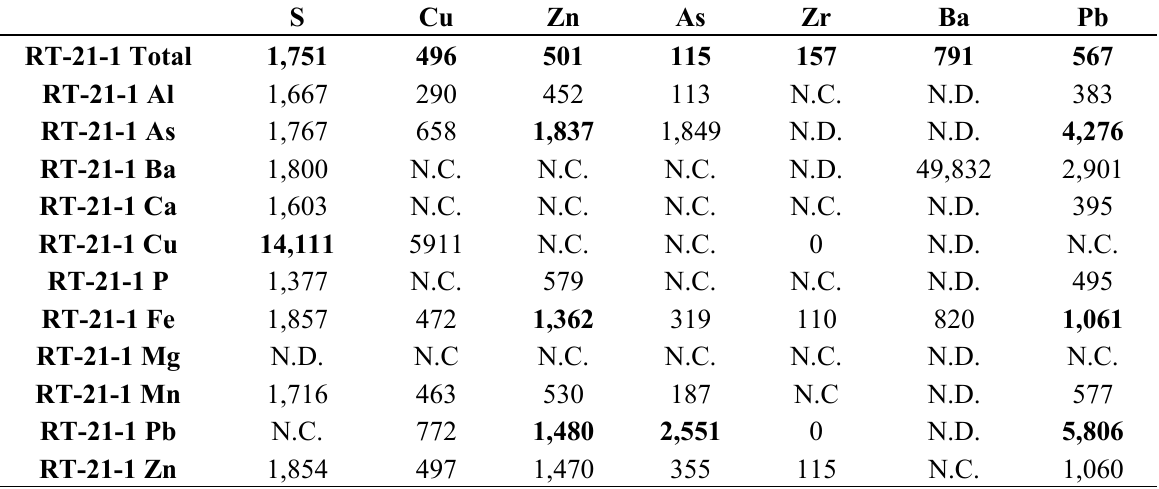
Table 12. Chemical analysis of trace elements (mg/kg) by PIXE of the total sample and accumulations indicated in elemental